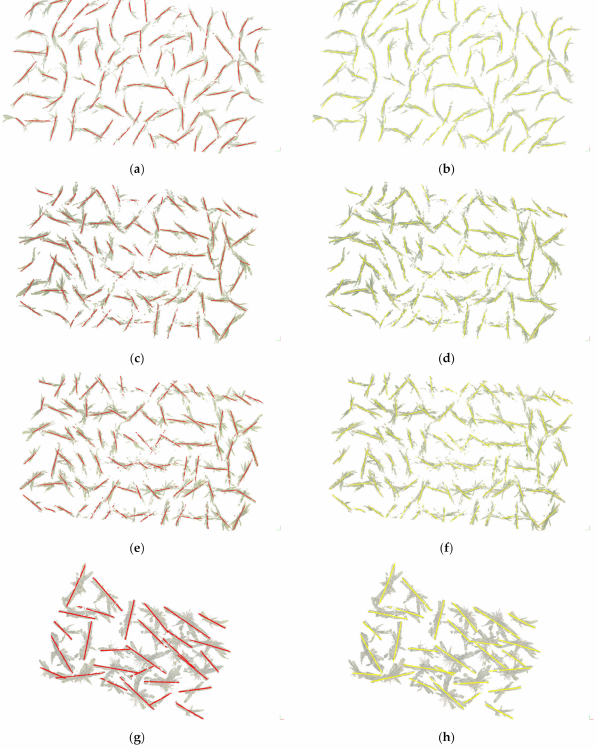
Figure 9. Prediction of plant growth trends. ( a ) Standard value of growth trend for Maize-01 ; ( b ) Predicted value of growth trend for Maize-01 ; ( c ) Standard value of growth trend for Maize-02 ; ( d ) Predicted value of growth trend for Maize-02 ; ( e ) Standard value of growth trend for Maize-03 ; ( f ) Predicted value of growth trend for Maize-03 ; ( g ) Standard value of growth trend for Maize-04 ; ( h ) Predicted value of growth trend for Maize-04